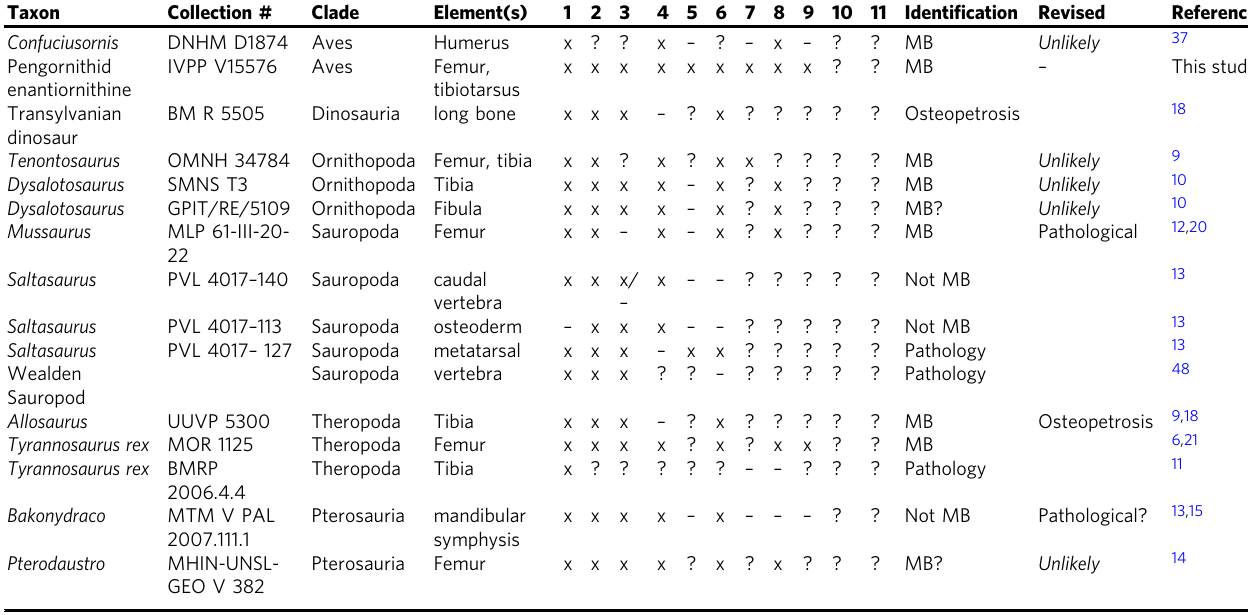
Table 2 All previously described occurrences of purported MB in Mesozoic fossils scored across the nine features (Table 1) that, together, should allow identi fi cation of preserved tissue as MB (present indicated by x, absence with a